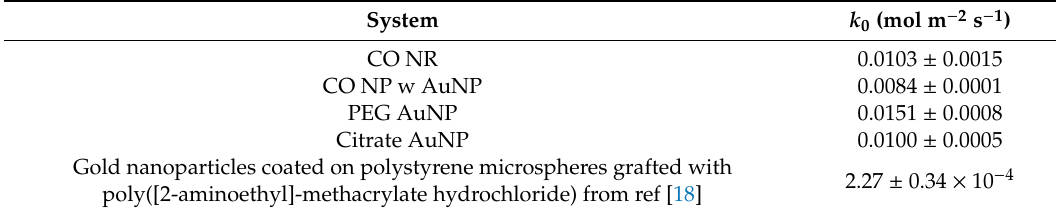
Table 3. Langmuir–Hinshelwood single-step fitted kinetic